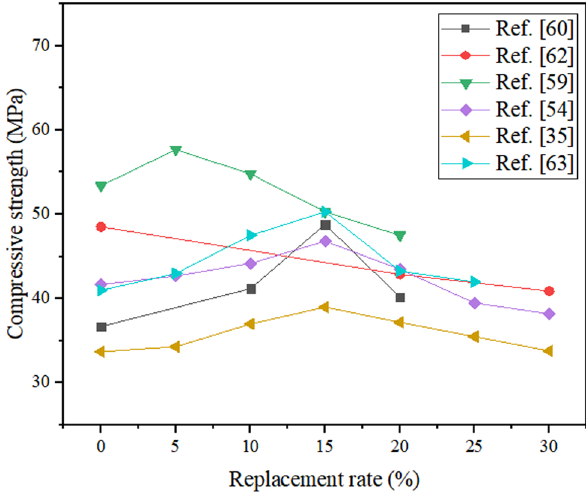
Figure 6: Compressive strength of RHA – SCC [ 35,54,59,60,62,63 ] .